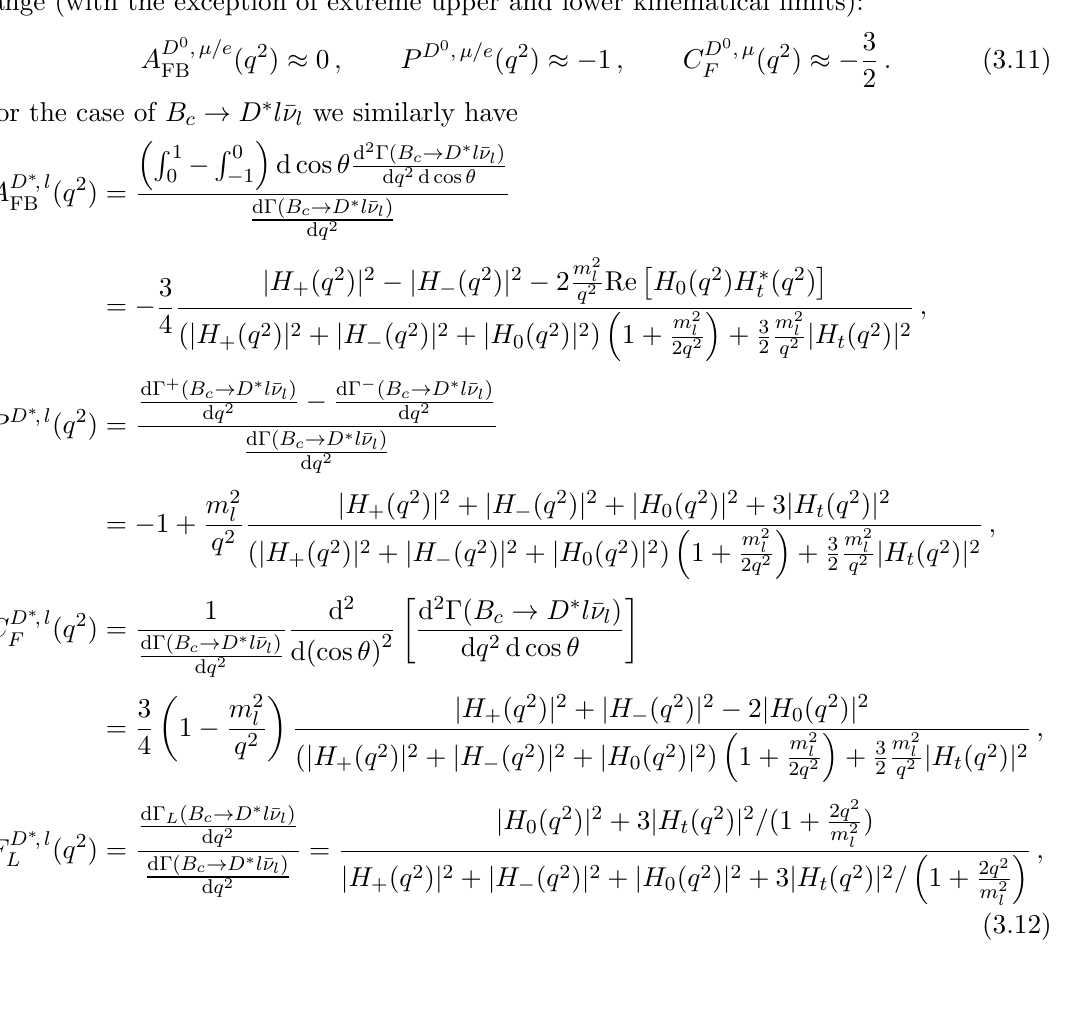
Figure 7 . Ratios of di(cid:11)erential partial decay rates B c semileptonic transitions to D (left), and to D (cid:3) (right) with tau in the (cid:12)nal state to the case with muon in the (cid:12)nal state. the asymmetries with light leptons in the (cid:12)nal state are basically constant in the entire q 2 range (with the exception of extreme upper and lower kinematical